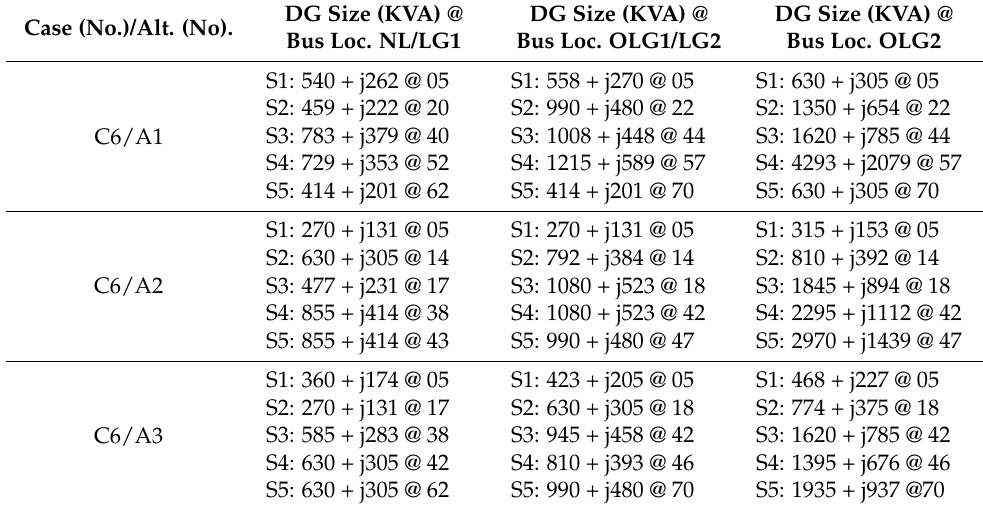
Table 25. Asset set (REG+D-STATCOM) sitting and sizing equal to DG operating at 0.9 LPF for C6/S1–S5 across alternatives in the extended 75-bus